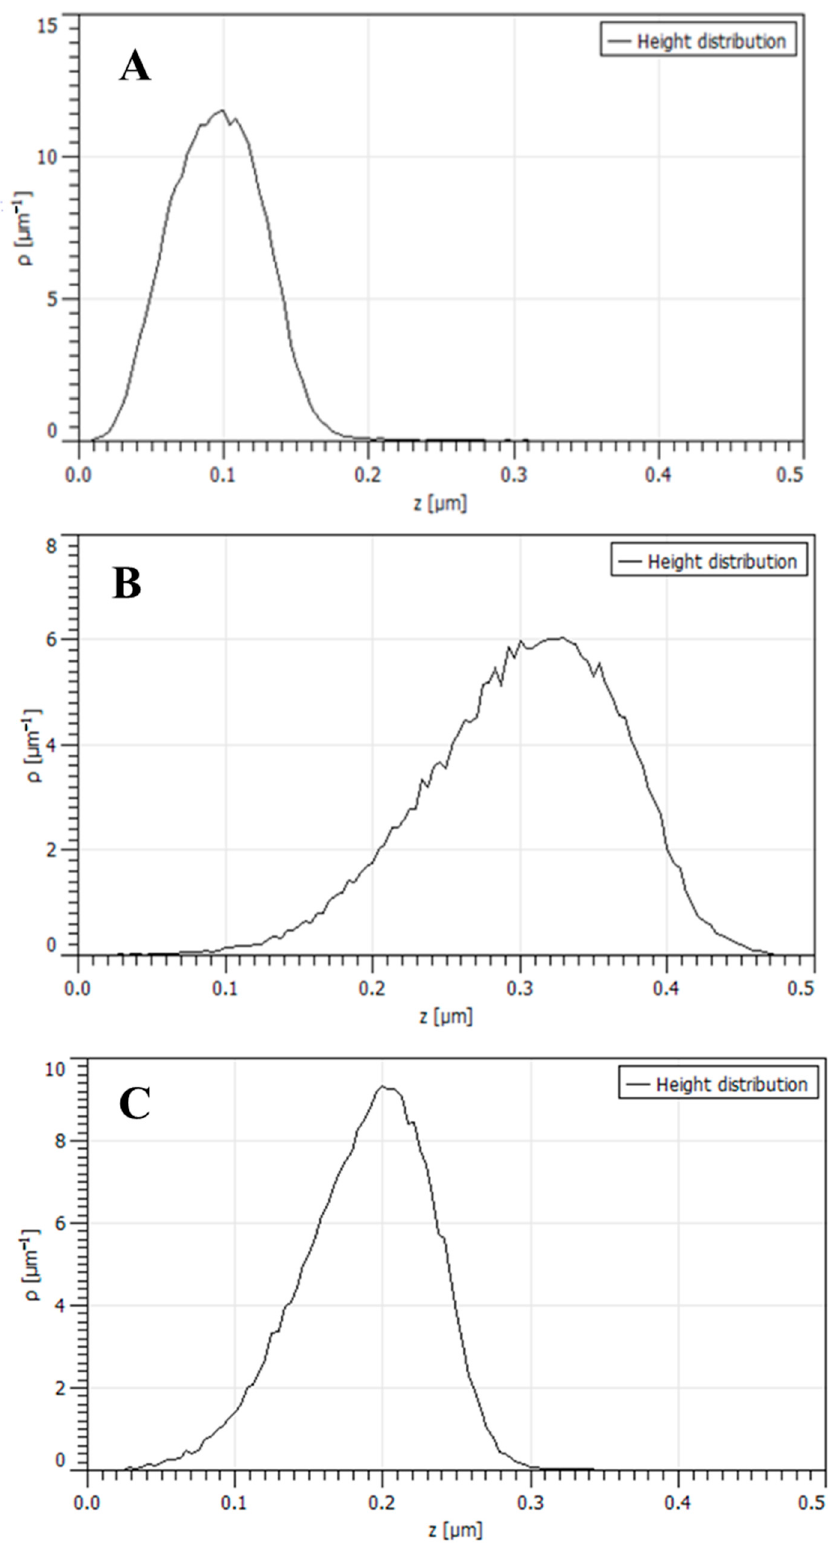
Figure 9. Histograms of the height distribution measured by AFM: ( A )—before plasma treatment, ( B )—after plasma treatment, ( C )—the same sample as in B stored for four weeks under ambient conditions.